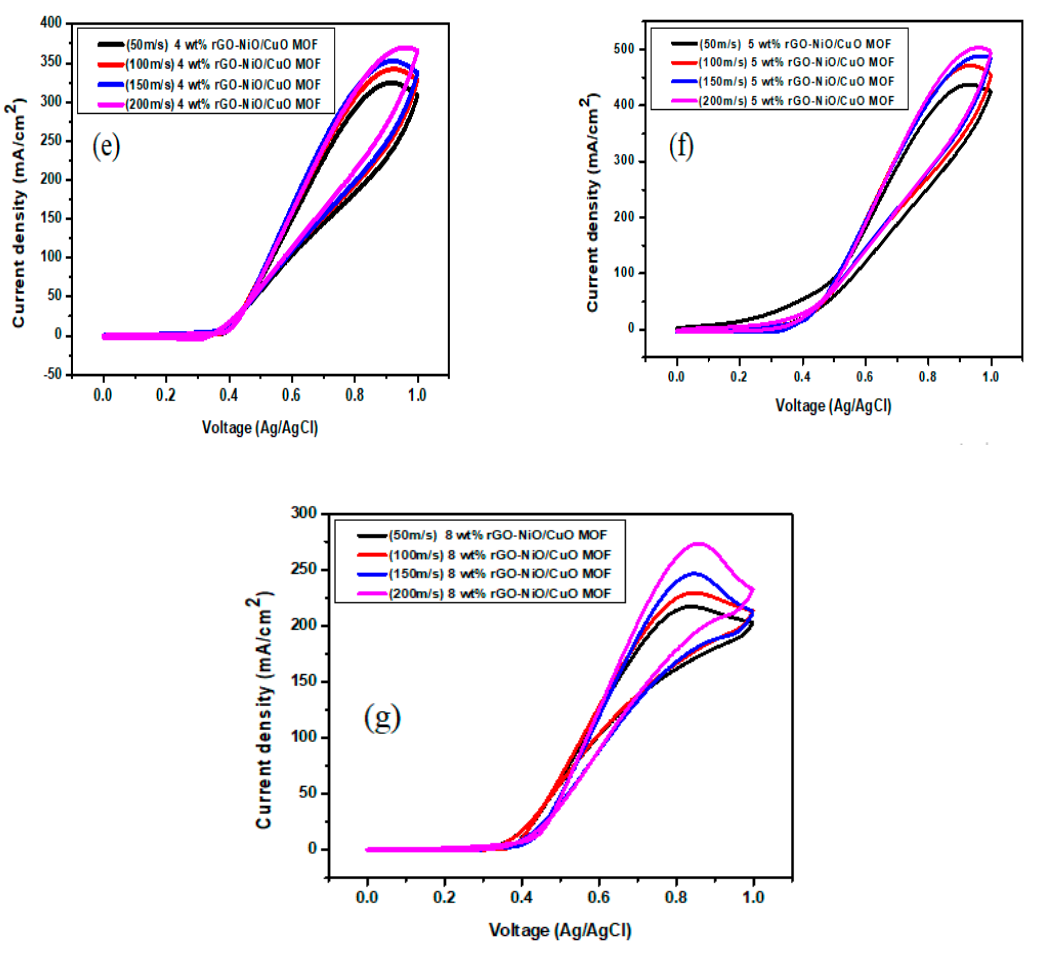
Figure 6. Cyclic Voltamograms of ( a ) NiO / CuO MOF and its composites with ( b ) 1 wt% ( c ) 2 wt% ( d ) 3 wt% ( e ) 4 wt% ( f ) 5 wt% ( g ) 8 wt% rGO-NiO / CuO MOF at scan rate 50–200 mV / s in 3M methanol and 1M NaOH. Table 2. Comparison of methanol concentrations, scan rates and current densities along with reported electro catalysts for methanol